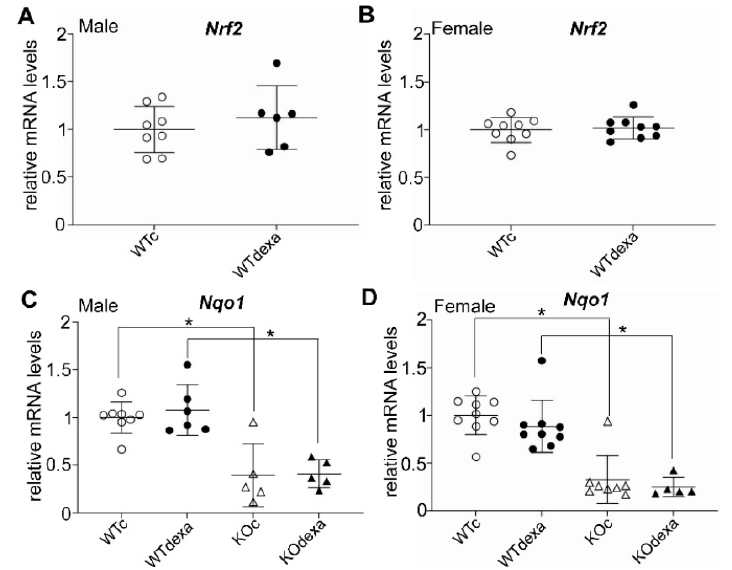
Figure 6. Relative mRNA expression of Nrf2 and its prototypical target gene Nqo1 in liver of male ( A , C , respectively) and female ( B , D , respectively) WT or Nrf2 KO mice treated with vehicle or dexamethasone. * p < 0.05 of the indicated comparison. WTc: wild-type control (vehicle-treated); KOc: Nrf2 knockout control (vehicle-treated); WTdexa: wild-type dexamethasone-treated; KOdexa: Nrf2 knockout dexamethasone-treated.